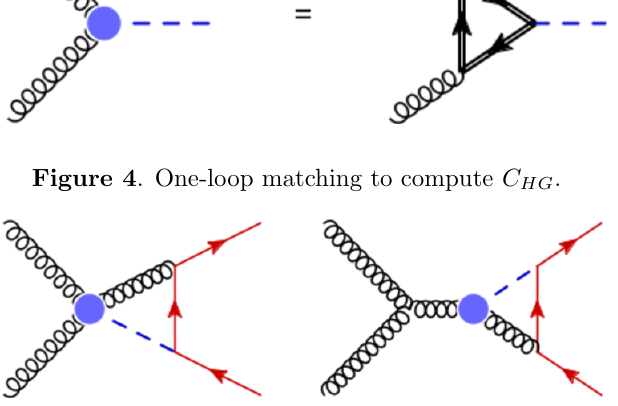
Figure 5 . Selected UV divergent diagrams in non-factorisable contributions from the Lagrangian in eq.